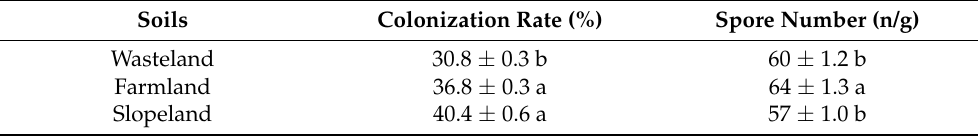
Table 2. AMF infection characteristics. The data in the table are the mean ± standard deviation of 4 replicates, and the different lowercase letters indicate significant differences among treatments ( p < 0.05), respectively.